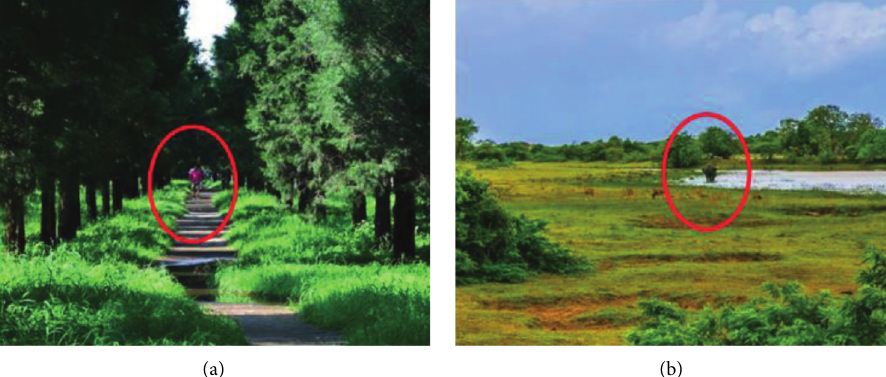
Figure 1: Two examples. (a) If there are no big animals in this area, this object is more likely to be a person. (b) If there is no human activity in this area, this object is more likely to be an